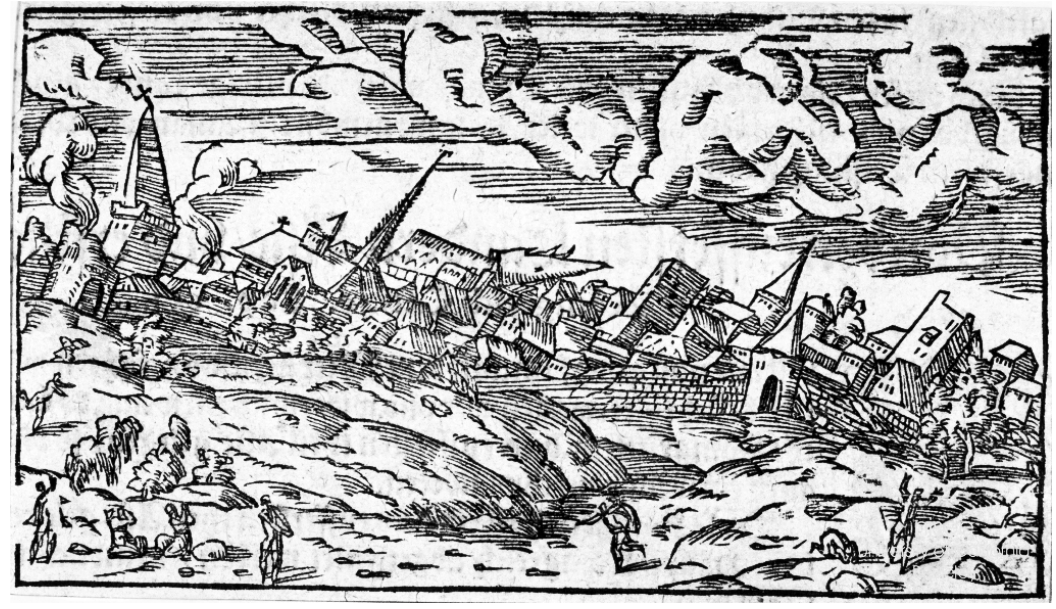
Figure 1: Sixteenth-century European woodcut print showing the paradigmatic repertoire of picturing